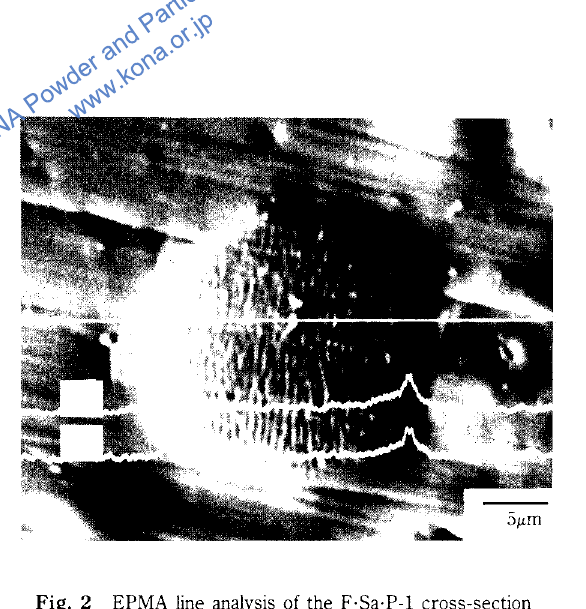
Fig. 2 EPMA line analysis of the F·Sa·P-1 cross-section